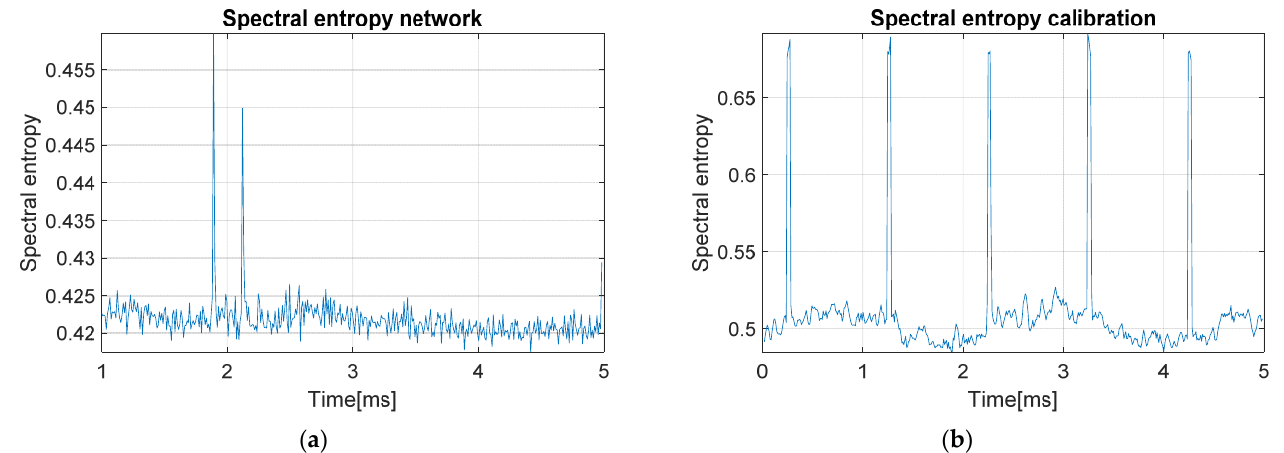
Figure 12. ( a ) Spectral entropy of the network signal; ( b ) spectral entropy of the calibration signal.